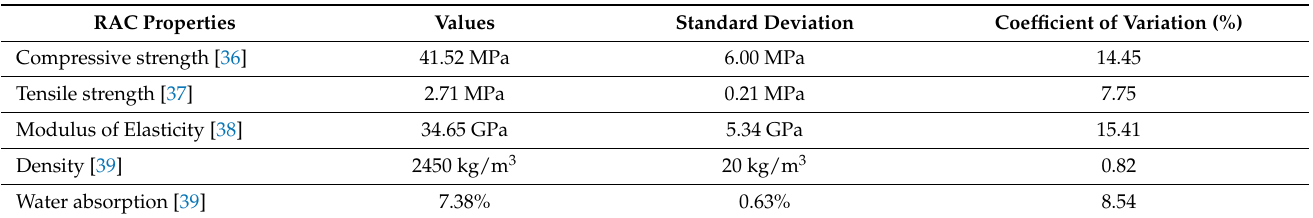
Table 5. Physics and mechanical characteristics of recycled coarse aggregate